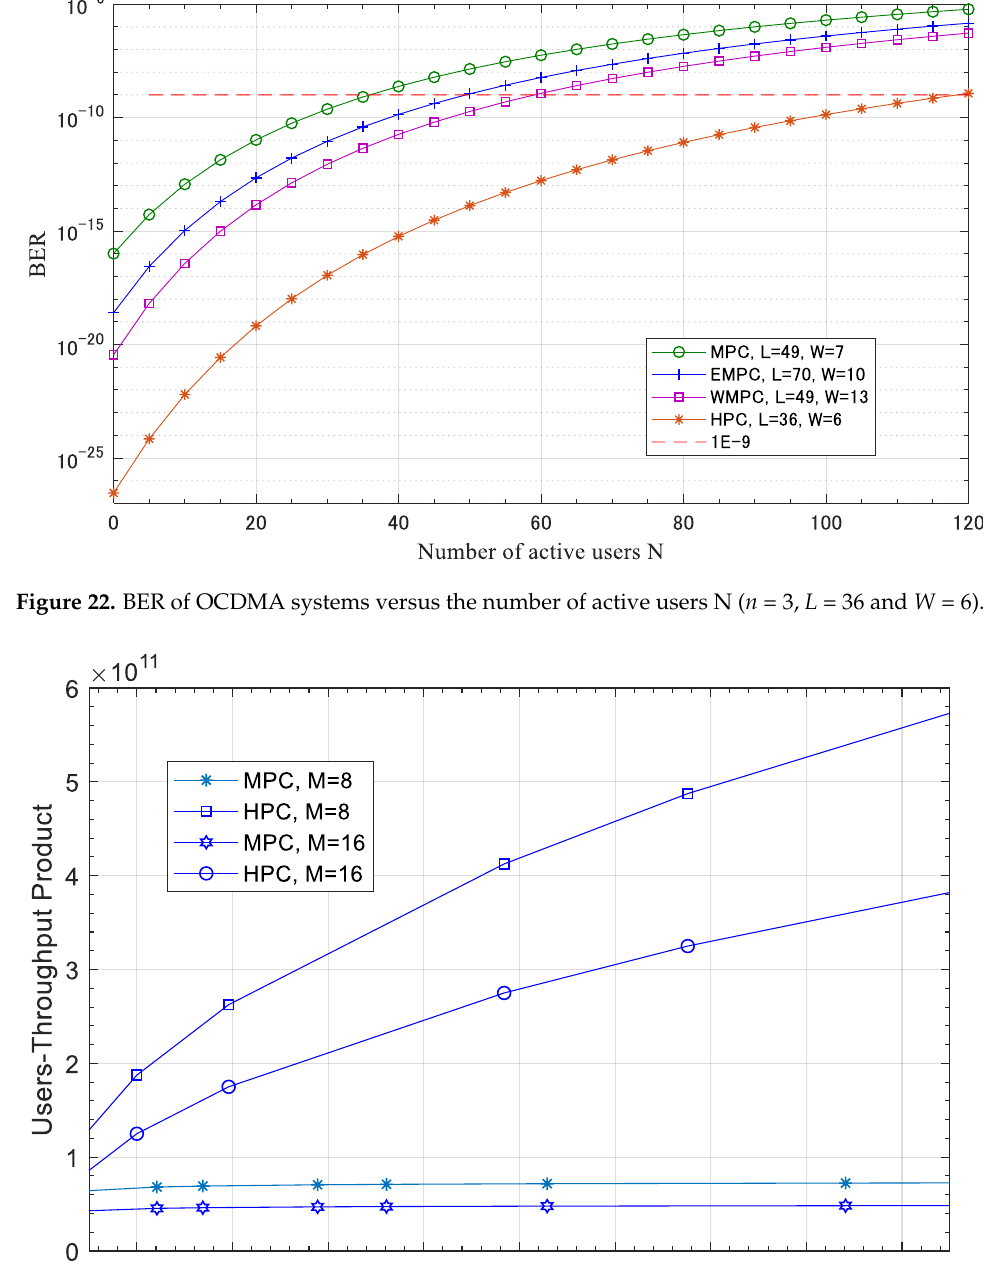
Figure 21. BER of OCDMA systems versus the number of active users N ( n = 2, L = 24 and W = 4).